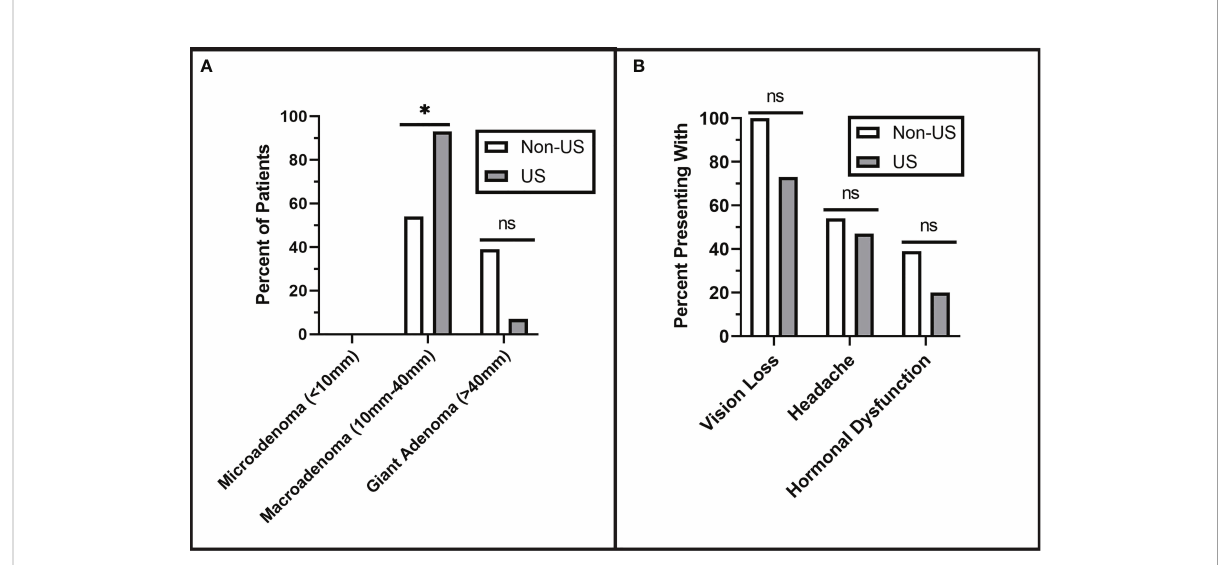
FIGURE 2 Preoperative Tumor Characterization. (A) Pituitary adenomas were classi fi ed by size. No microadenomas were observed in either group. The US group had signi fi cantly more macroadenomas than the non-US group (p = 0.029). (B) There were no signi fi cant differences in the rates of presenting symptoms including vision loss (p = 0.102), headache (p = 0.705), and hormonal dysfunction (p = 0.410). Asterisks (*) indicate signi fi cance of p < 0.05. Values that did not reach the threshold for signi fi cance (p= <0.05) were labeled as non-signi fi cant (ns).